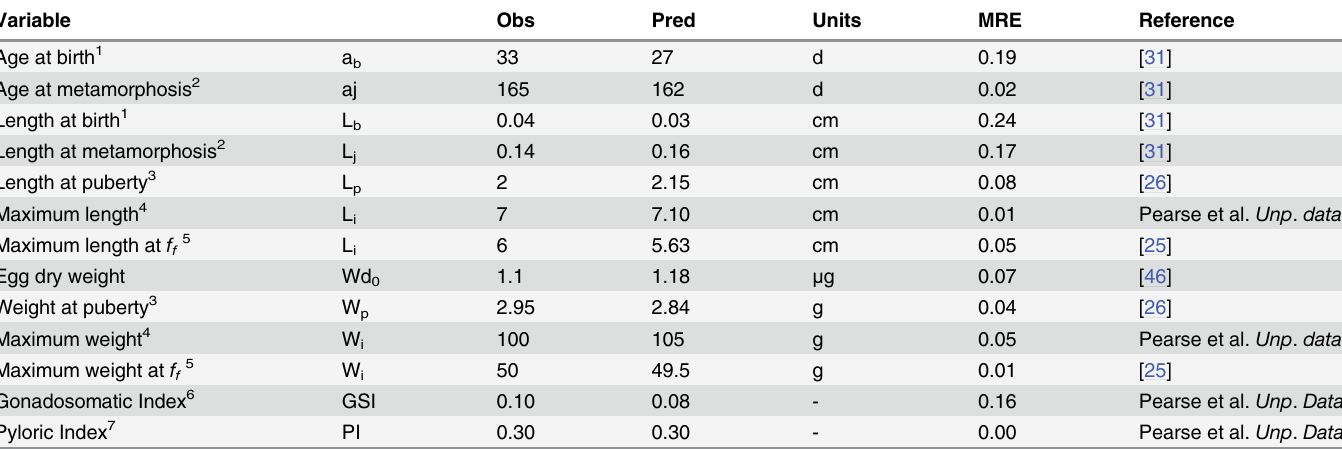
Table 2. Zero-variate data used for the estimation of the DEB model parameters. All values are given at a temperature of 271.5 K. This is the tempera- ture at which these values where measured. MRE: mean absolute relative